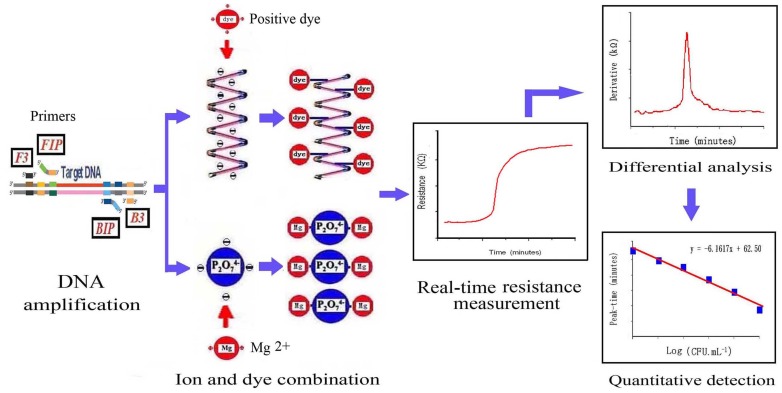
Scheme of the real-time resistance measurement for V. parahaemolyticus.Briefly, the lecithin-dependent hemolysin (LDH) gene of V. parahaemolyticus was amplified by LAMP at first. The subsequent two products, DNA and pyrophosphate, both negative ions, were combined with a positive dye (Crystal violet) and positive ions (Mg2+), leading to an increase in the reaction liquid resistance. This resistance was measured in real-time using a electrode, and V. parahaemolyticus concentration was quantitatively detected through a derivative analysis.